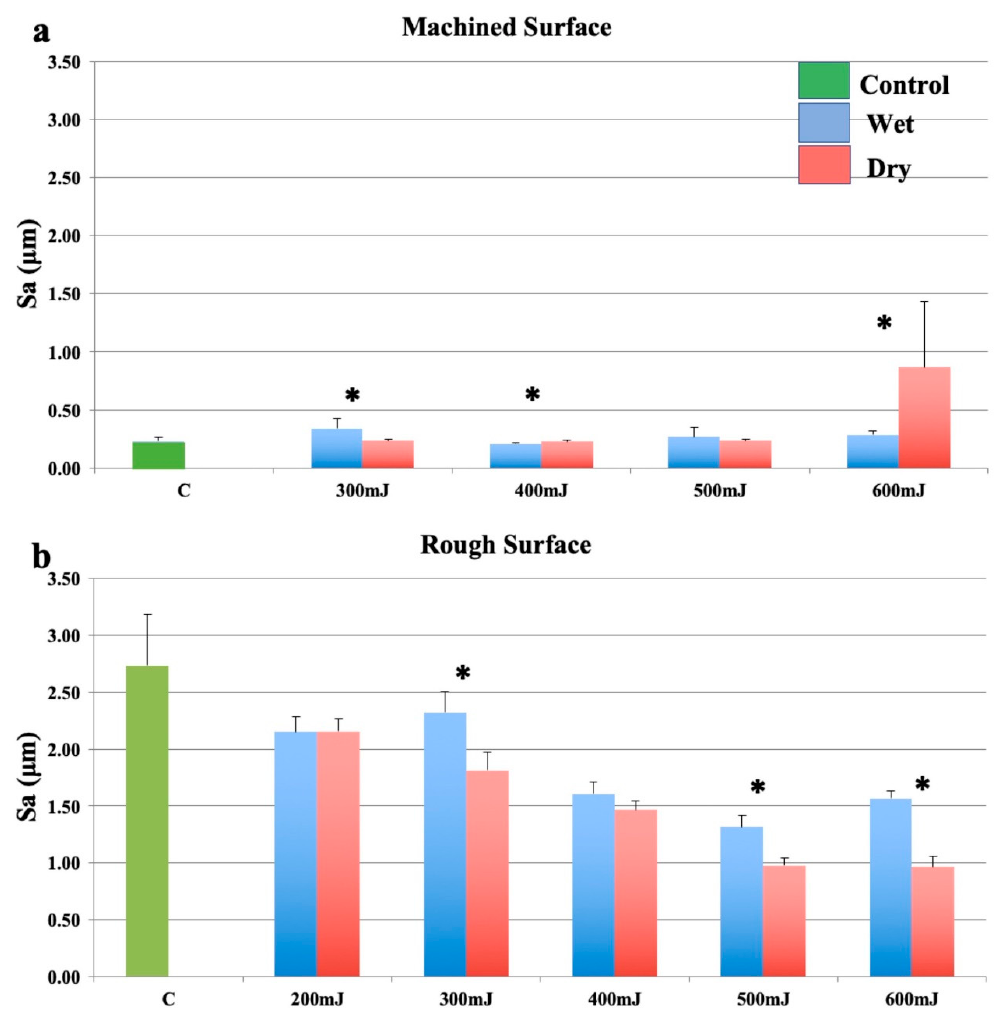
Figure 1. Effects of the Er:YAG laser with a focusing handpiece (2060). ( a ): Machined surfaces. ( b ): Roughened surfaces. Bars show controls (green), wet surfaces (blue), and dry surfaces (red). * indicates a significant difference between wet and dry conditions ( p < 0.05).